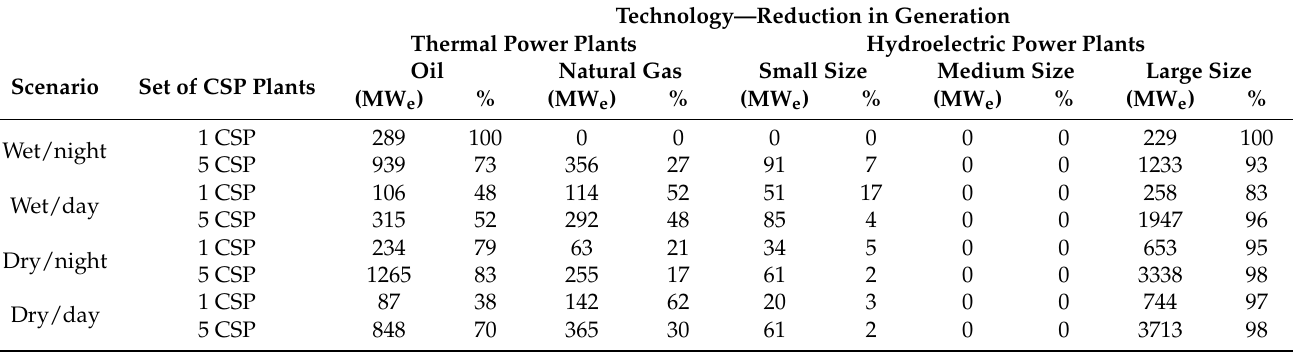
Table 6. Reduction in thermal and hydroelectric generation with the insertion of 1 CSP and 5 CSP in the hydrothermal system. Technology—Reduction in Generation Thermal Power Plants Hydroelectric Power Plants